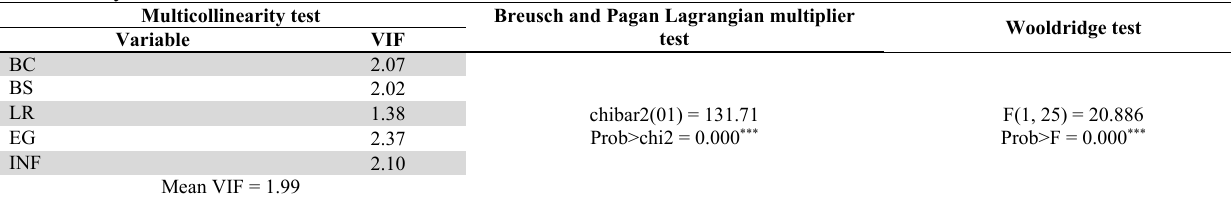
Test of study model